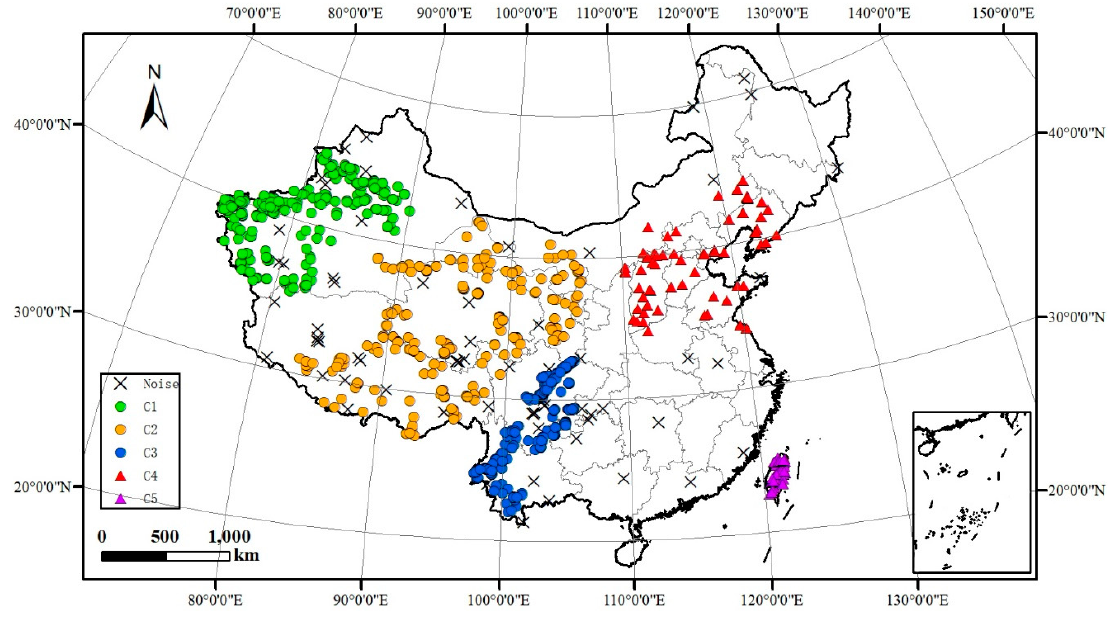
Figure 10. Clustering results for the earthquake database using the SCMDOT algorithm from the macroscopic view.